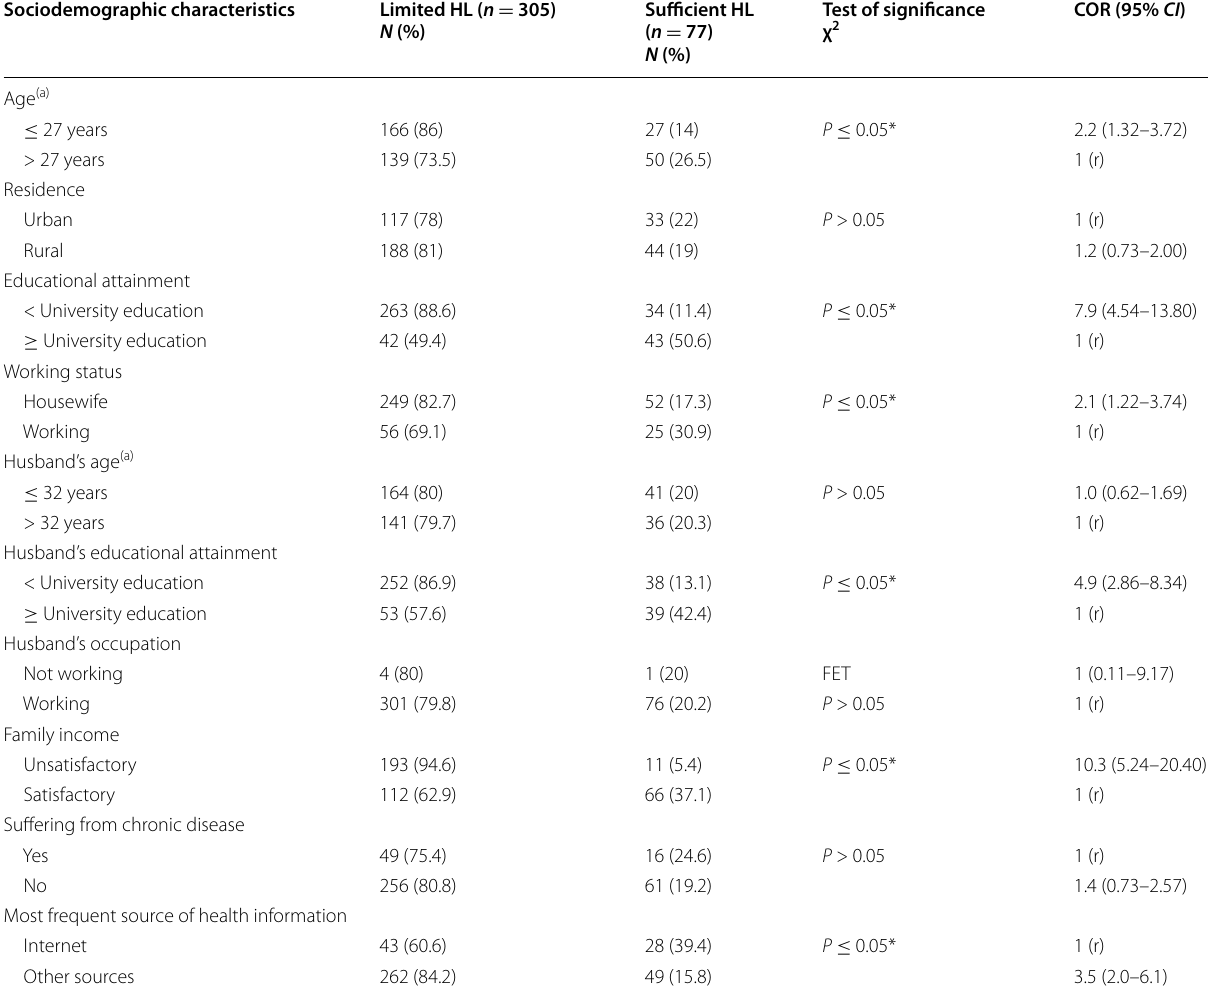
Table 2 Relationship between level of health literacy (HL) and sociodemographic characteristics of pregnant women attending ANC clinics in Mansoura district, Egypt, 2020 ( n =